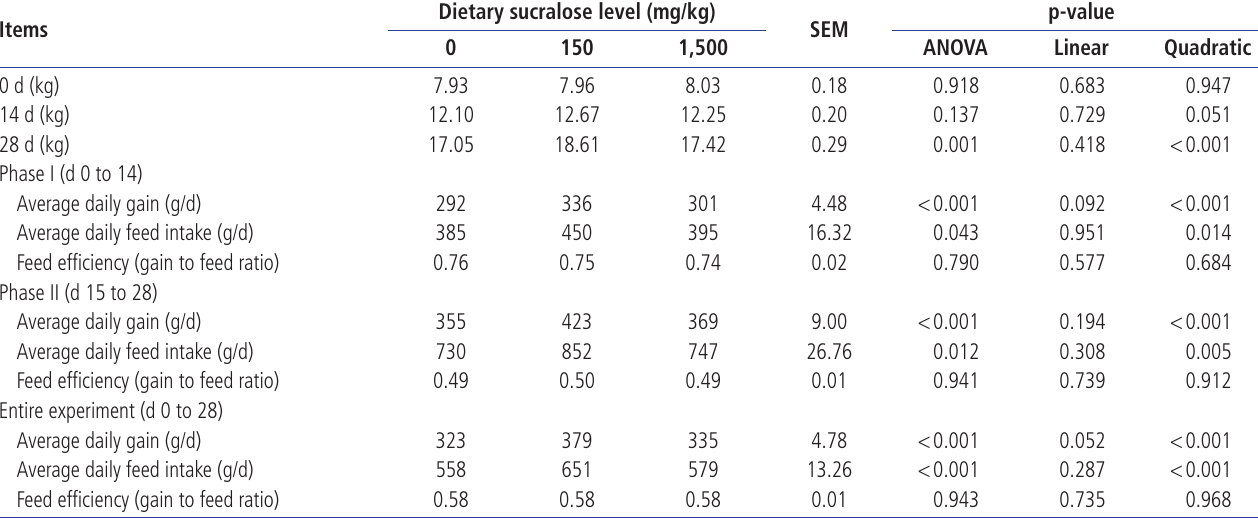
Dietary sucralose level (mg/kg)